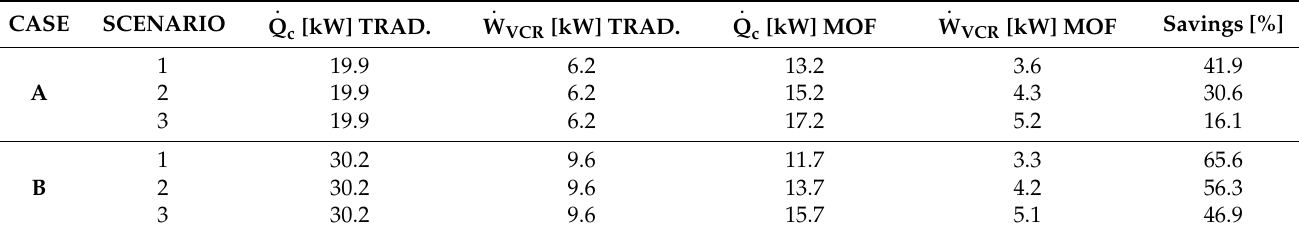
Table 4. Cooling power and electric power consumption for the two HVAC configurations.